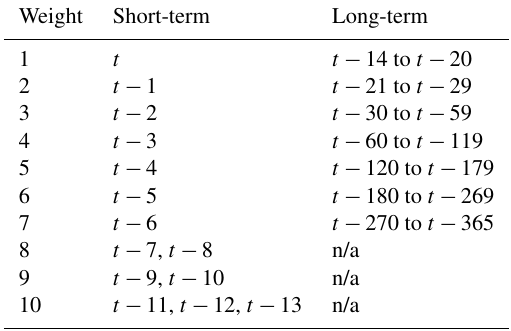
Table 3. Assignment of weights to lagged periods. The same weight is applied to multiple lag periods for the short-term predictors. Grouping of lags is necessary to reduce the number of parameters being estimated by the Bayesian framework, which improves model computing performance and reduces the risk of